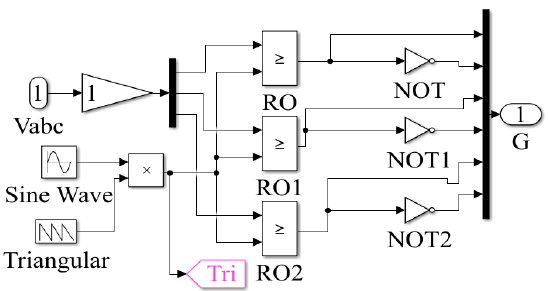
Figure 22. Space vector pulse width modulation (SVPWM) signal output model based on spread spectrum technology.